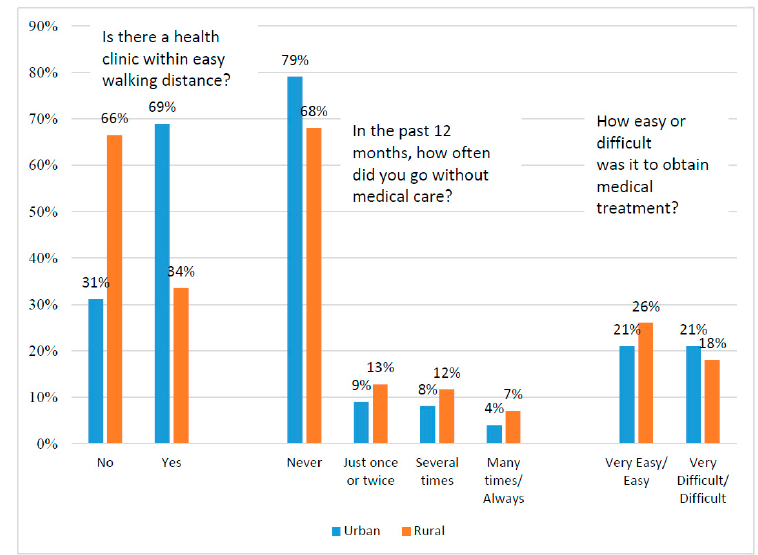
Figure 1. Availability of health services; 2014/2015: Source: Author’s construct.